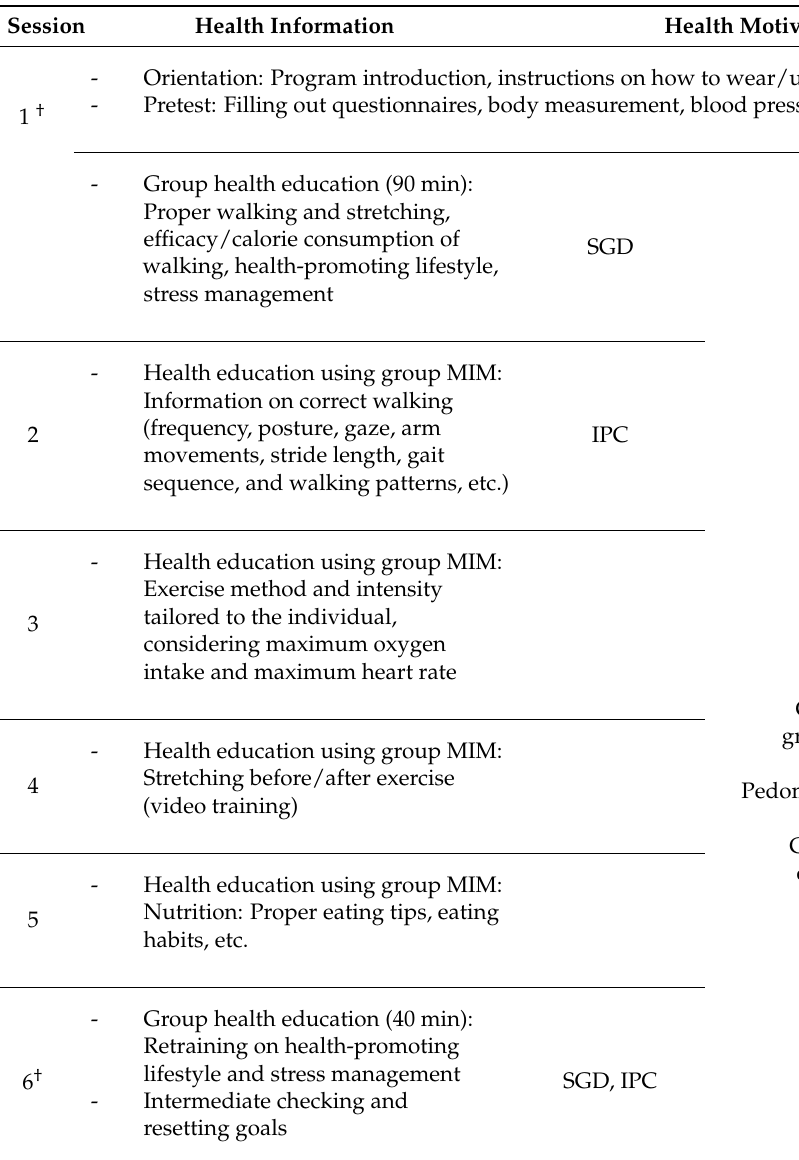
Table 1. Contents of each session of the health promotion